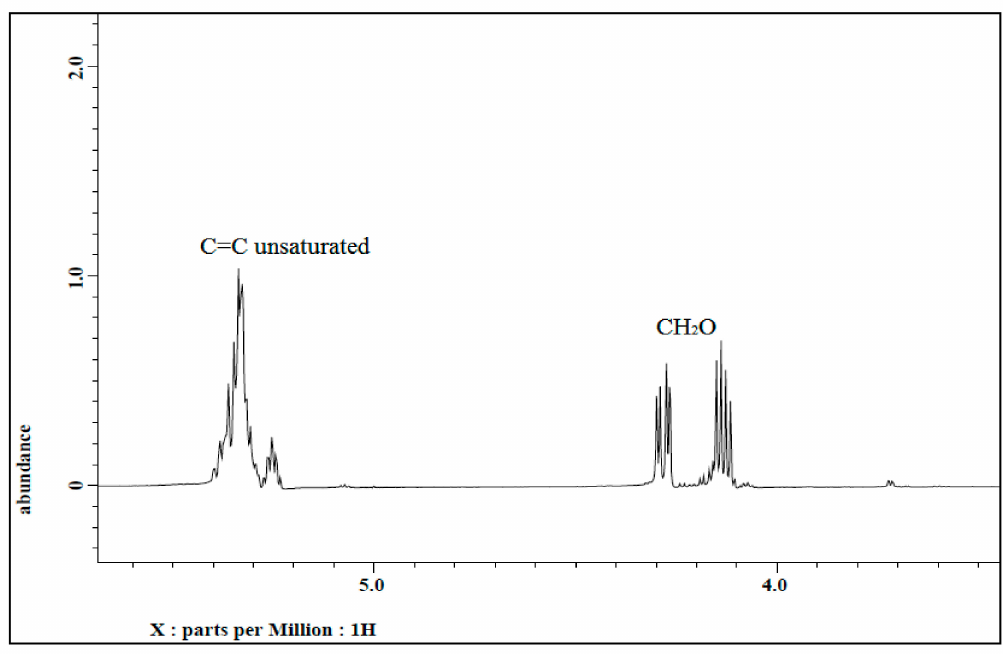
Figure 4. 1 H NMR spectrum of jatropha oil.